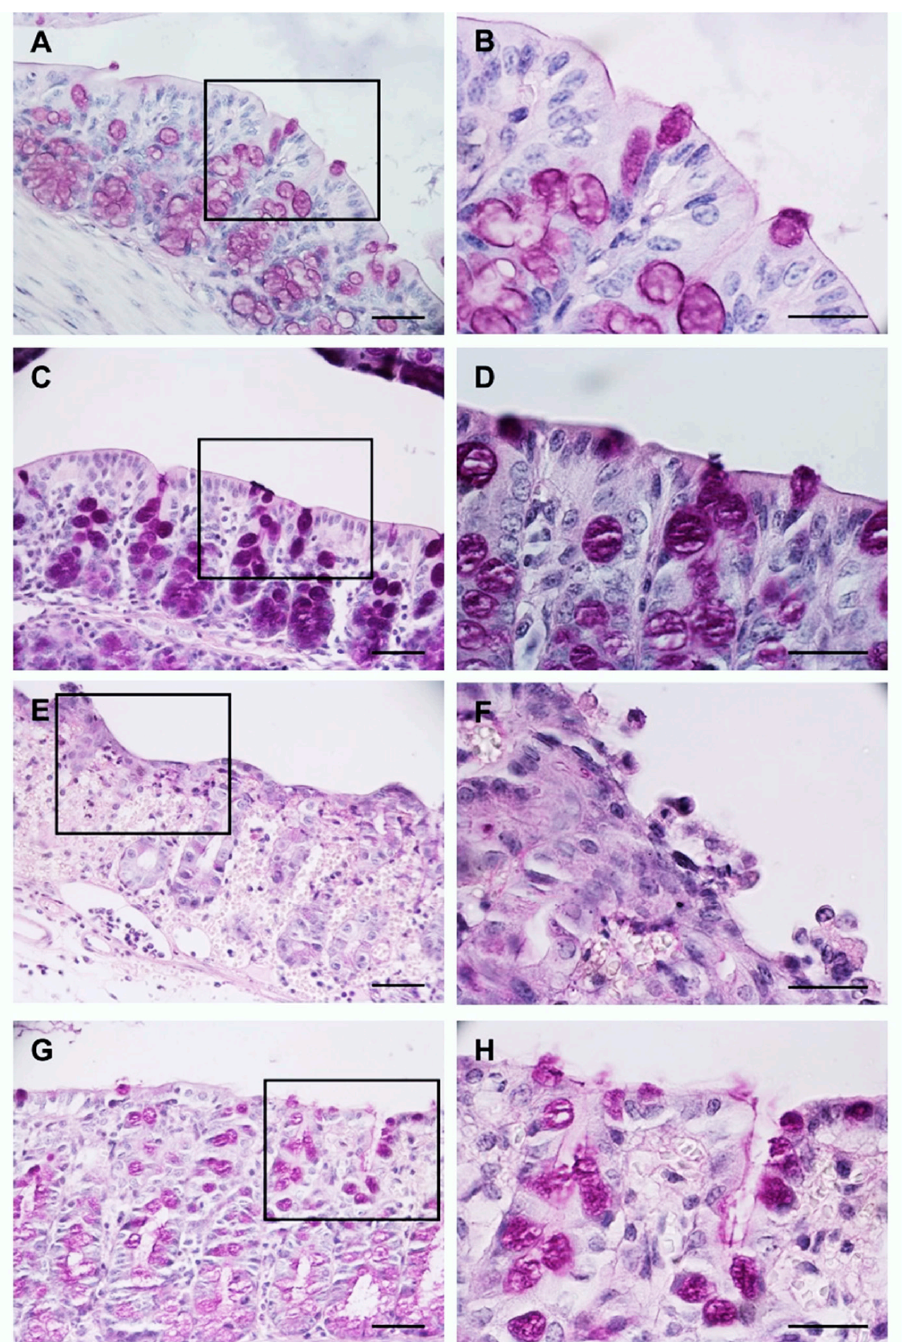
Figure 2. Evaluation of the morphology of the colon using the PAS histochemical stain. Images: ( A , C , E , G ) are at 40 × magnification, images: ( B , D , F , H ) represent 100 × magnification of the region marked with the rectangle in 40 × images. Scale bar: 100 µ m in all